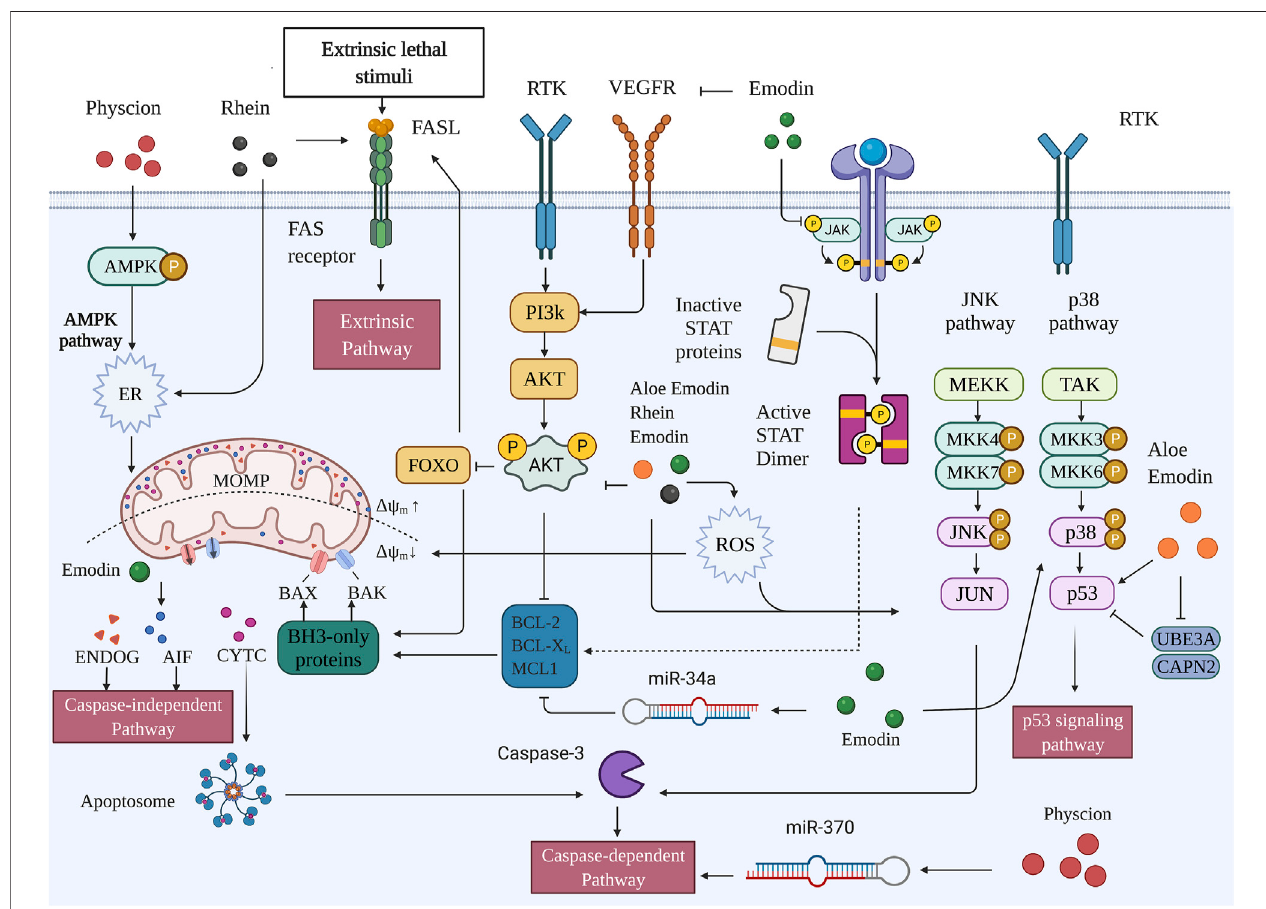
FIGURE 2 | Pro-apoptotic capacities of active metabolites of RR in HCC (Created with BioRender.com).